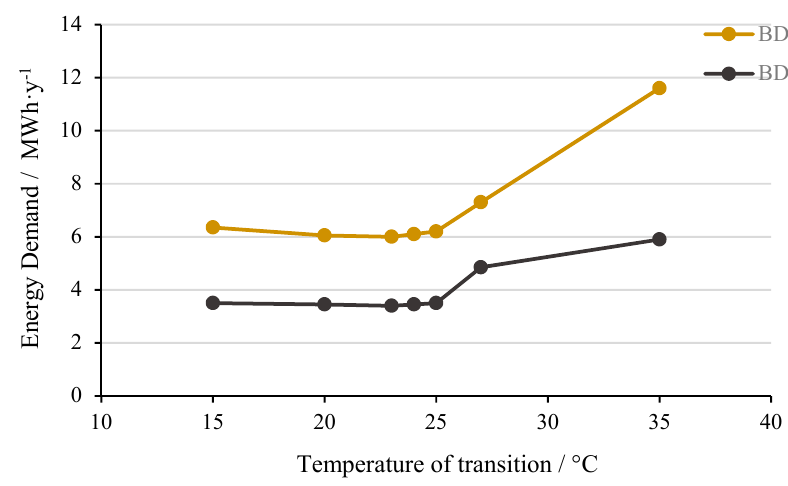
Figure 7. Annual energy demand, for building configurations BD1 and BD2 located in Abu Dhabi, United Arab Emirates, considering different transition temperatures for the thermochromic paint.